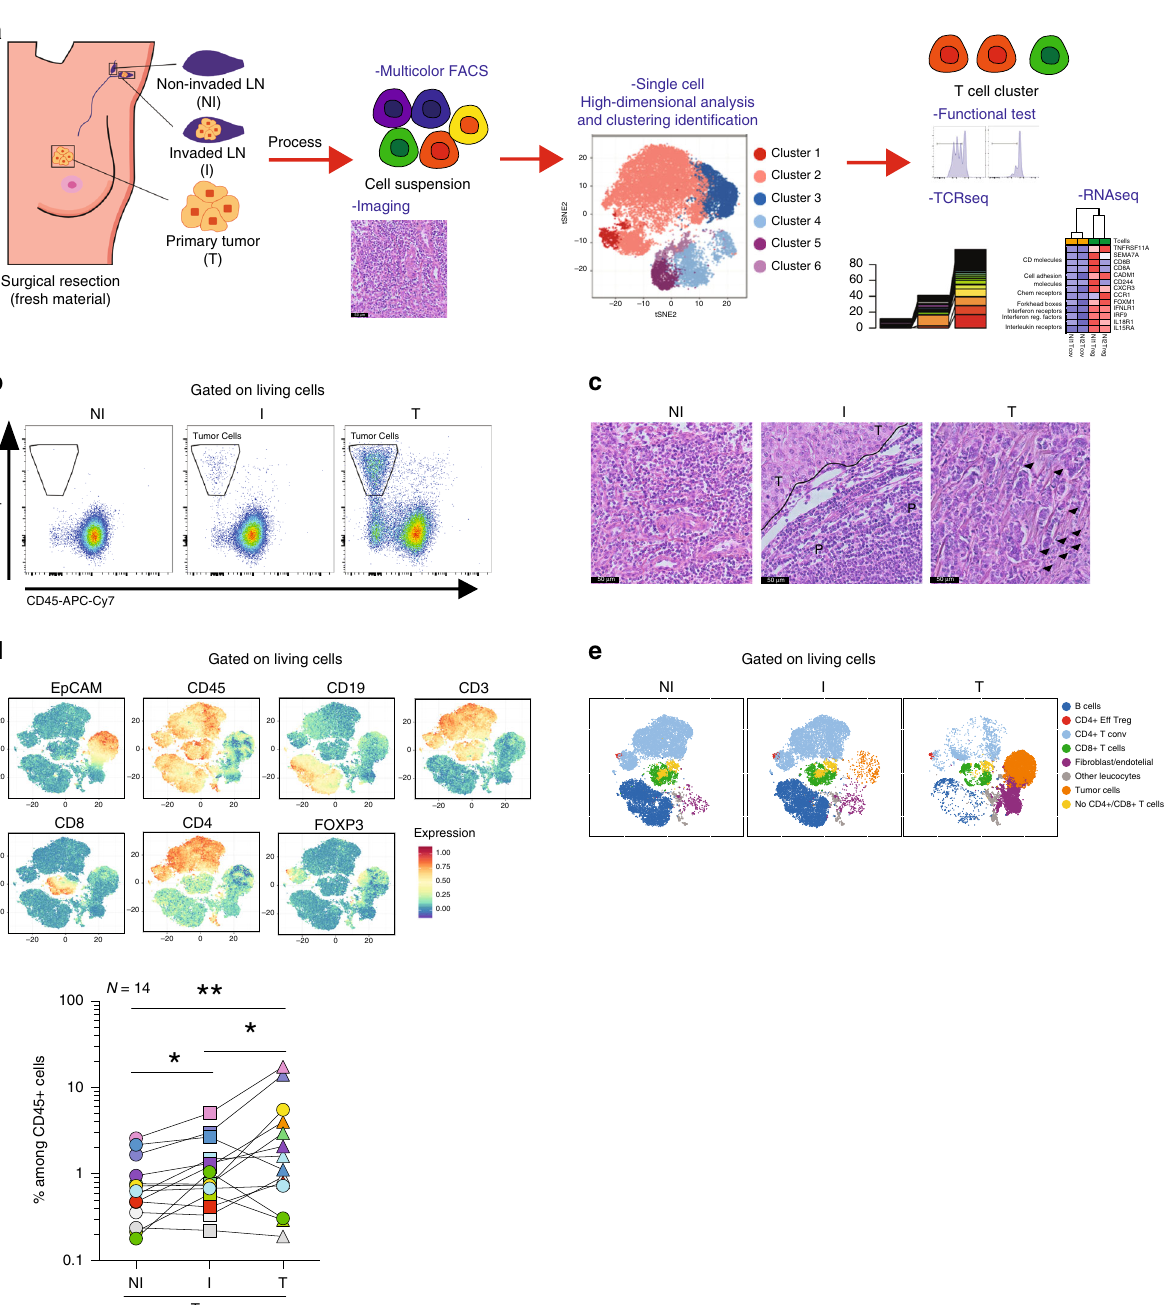
Fig. 1 Overall distribution of immune cell populations in NI and I TDLNs, and tumor. a Flowchart of the study design. Non-invaded (NI) and invaded (I) TDLNs, and the primary tumor (T) were collected and samples were split and processed for hematoxylin – eosin staining or for fl ow cytometry analysis, functional tests or transcriptome and TCR sequencing. b A representative fl ow cytometric analysis of EPCAM + CD45 + cell populations in NI and I TDLNs and primary tumors. c Representative hematoxylin – eosin staining of NI TDLNs (left panel), I TDLNs (middle panel), and primary tumors (right panel) (P: peritumor area; T: tumor area; arrows: leukocytes) from one out of three independent experiments with similar results. d Samples were stained with EpCAM, CD45, CD19, CD3, CD8, CD4, and FOXP3 and analyzed by FACS, and shown is a t-SNE map displaying randomly selected cells from TDLNs and primary tumors. e t-SNE map showing the FlowSOM-guided clustering of NI, I, and T cells. Each color represents a cluster and is associated with a different immune population. f Frequencies of Tregs among CD45 + cells in TDLNs and tumor (NI vs I TDLNs p = 0.0134; NI TDLN vs T p = 0.004; I TDLN vs T p = 0.0494). Wilcoxon matched-pairs signed rank test, * p < 0.05, ** p < 0.01 ( n =